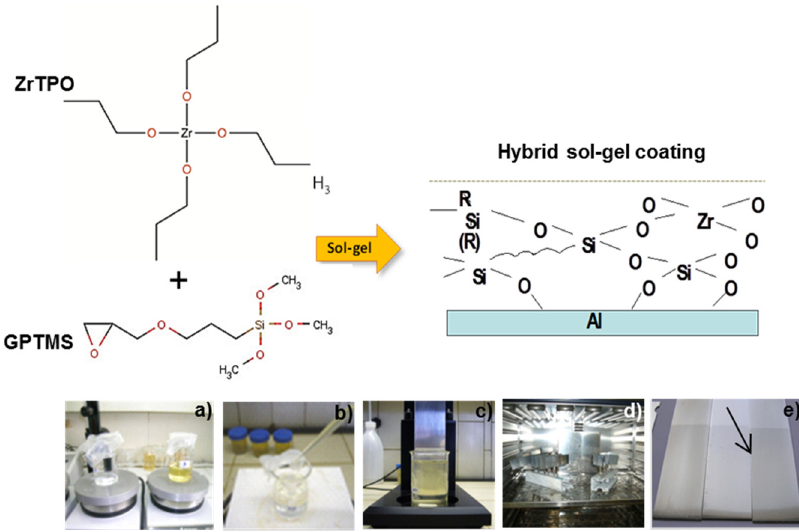
Figure 7. Hybrid sol ‐ gel coating synthesis and deposition steps in the laboratory: ( a ) separate hydrolysis of precursors (GPTMS and ZrTPO); ( b ) mixing sols; ( c ) dipping; ( d ) curing of aluminium substrates; and ( e ) visual aspect of sol ‐ gel coated samples.